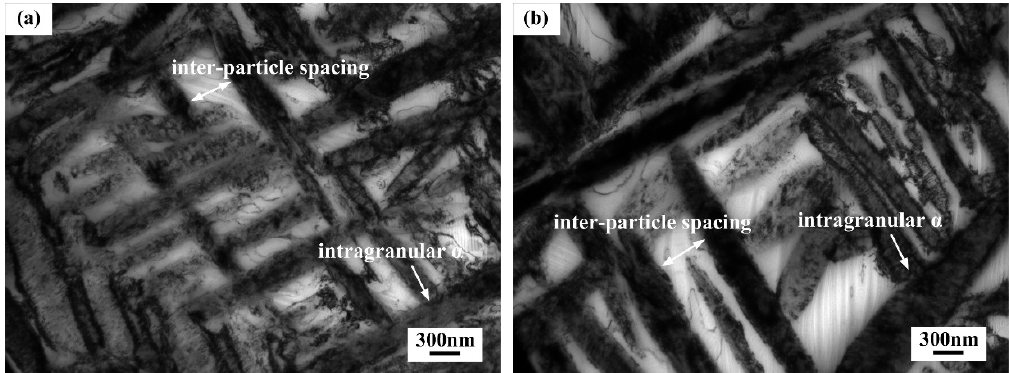
Figure 7. TEM micrographs of intragranular α phase in the alloy aged at 600 °C for ( a ) 8h ( b ) 16 h.